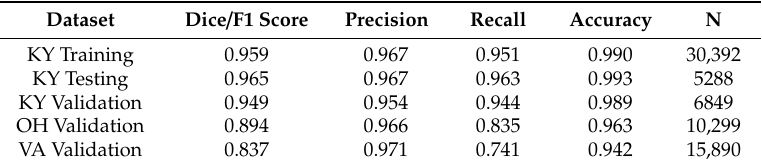
Table 4. Validation results using image chips. N = number of chips in the dataset.